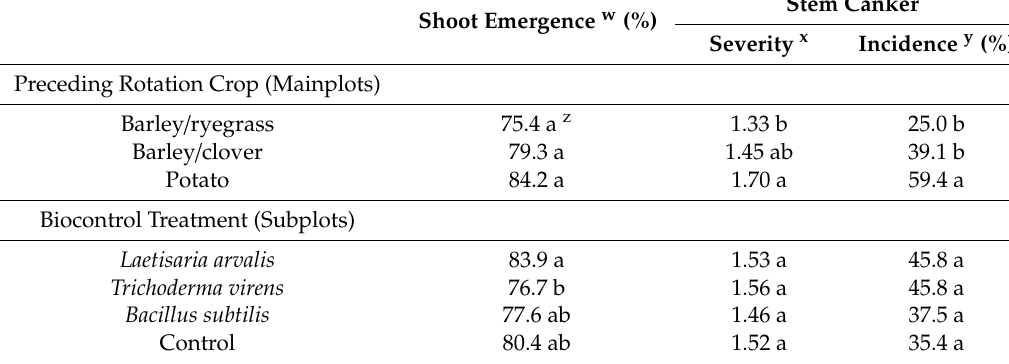
Table 2. Rhizoctonia disease ratings by preceding rotation crop or biocontrol treatment at location 1 (Central Maine). Shoot Emergence w